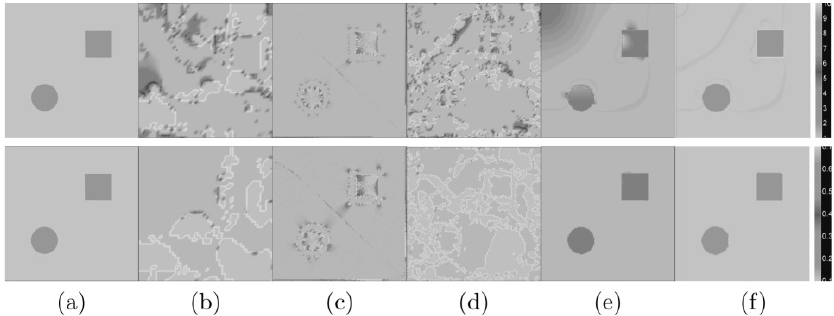
Figure 4. Case 1: Simulation results for µ (first row) and η µ (second row) image reconstruction. (a) True images; (c) direct inversion method; (e) hybrid one-step method; (b), (d) and (f) are reconstructed images by the adjoint-based optimization method (2.13) with initial guess of the constant µ 0 + iωη µ , (c) and (e), 0